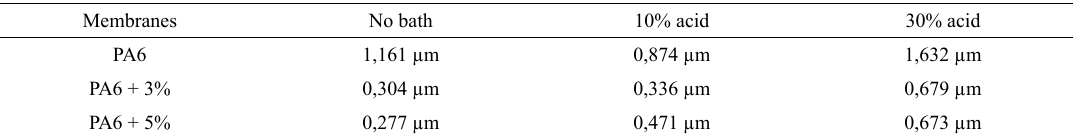
Figure 6. SEM images of the membranes surface with precipitation bath with 30% of formic acid: (a) PA6; (b) PA6 + 3% MMT and (c) PA6 + 5% MMT Table 1. Pore size at the surface to all the membranes